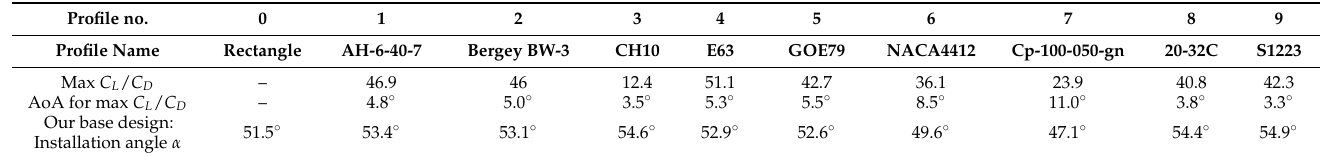
Figure 4. New boss cap and propeller with base design of representative airfoil PBCFs. ( a ) New boss cap facilitating fin installation. ( b ) Airfoil—terminology and dimension. ( c ) Base design of PBCFs of profile 1, AH-6-40-7. ( d ) Base design of PBCFs of profile 4, E63. ( e ) Base design of PBCFs of profile 6, NACA4412. Table 4. Ten boss cap fin profiles: their max lift/drag ratio and angle of attack (AoA, i.e., the angle between flow direction and chord line), and their installation angles finally used in our base